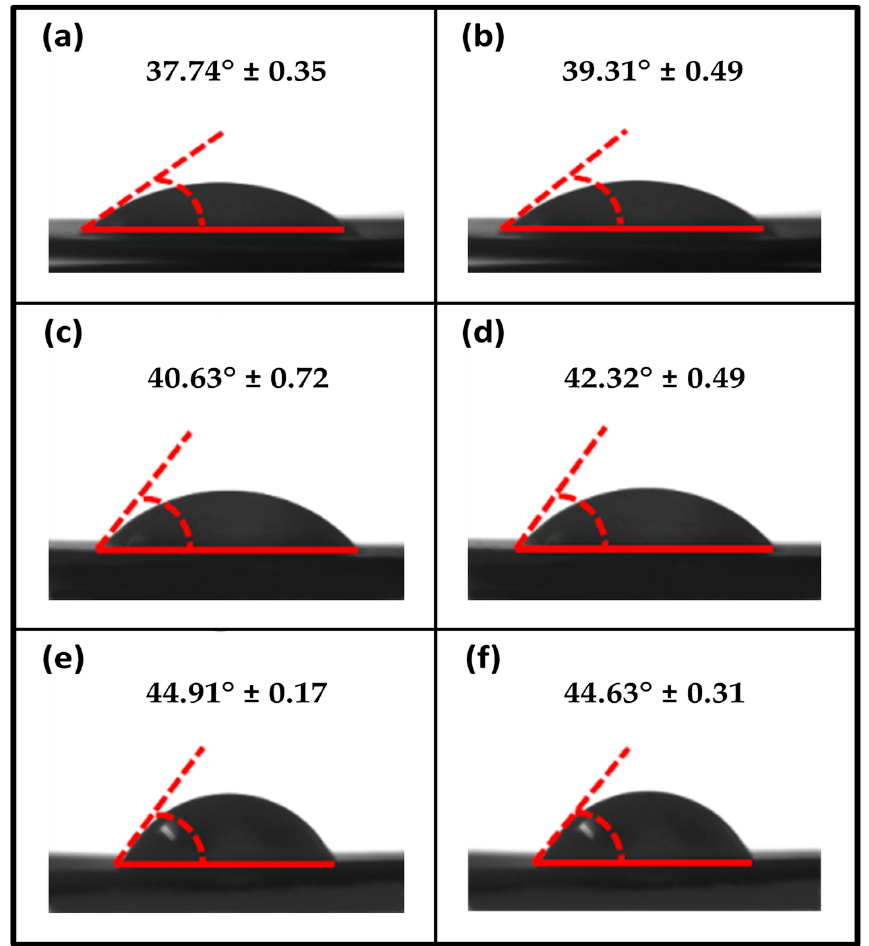
Figure 5. Water contact angle (WCA) of seaweed/coffee biopolymer film at different coffee concen- trations: ( a ) control, ( b ) coffee 1 wt%, ( c ) coffee 2 wt%, ( d ) coffee 3 wt%, ( e ) coffee 4 wt% and ( f ) coffee 5 wt%.